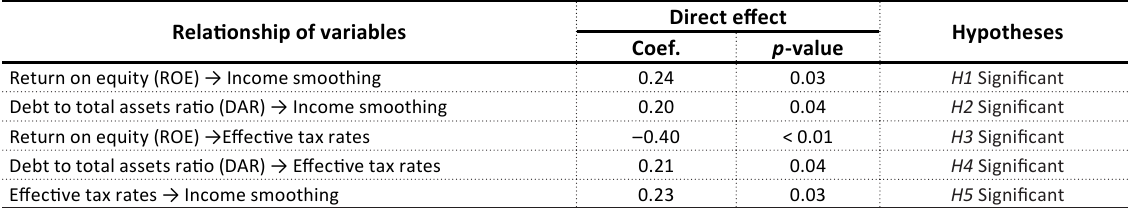
Table 3. Hypotheses testing results of direct effects